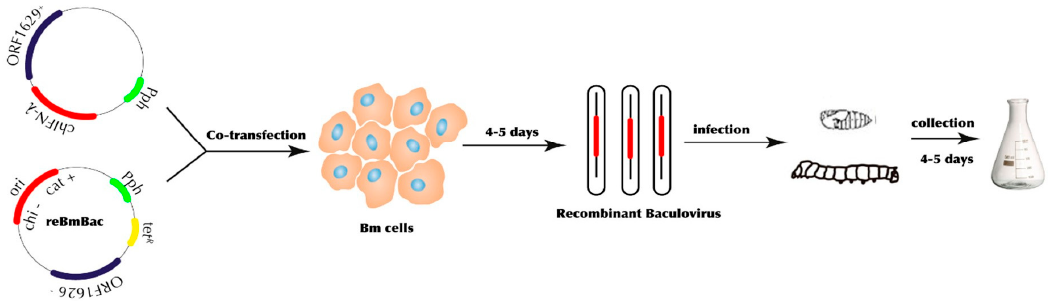
Figure 1. Construction strategy of recombinant baculovirus by employing silkworm expression vector system (BEVS).